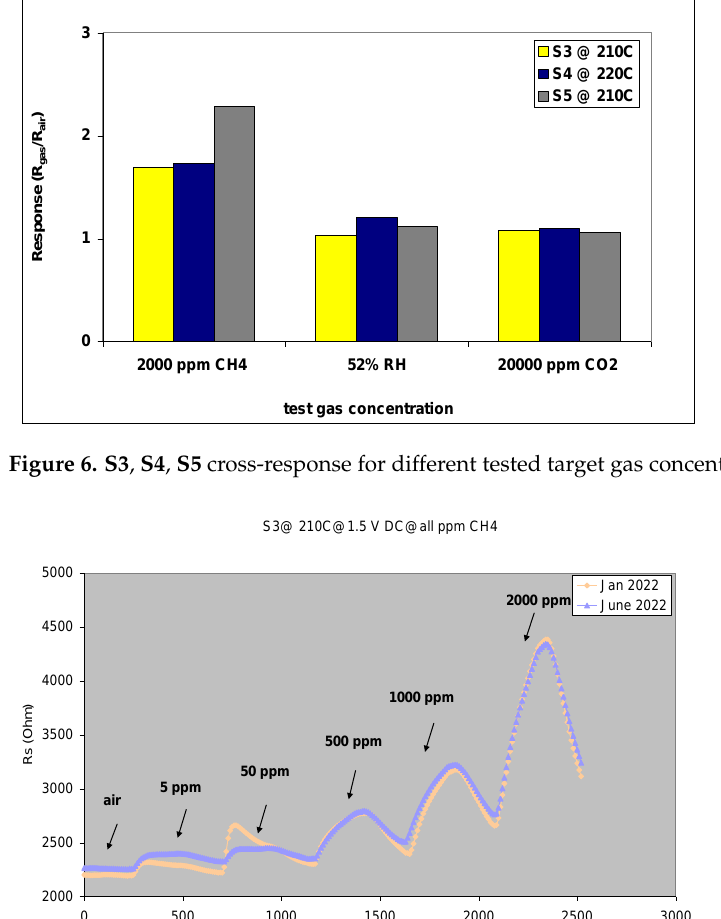
Figure 6. S3 , S4 , S5 cross-response for different tested target gas concentrations.